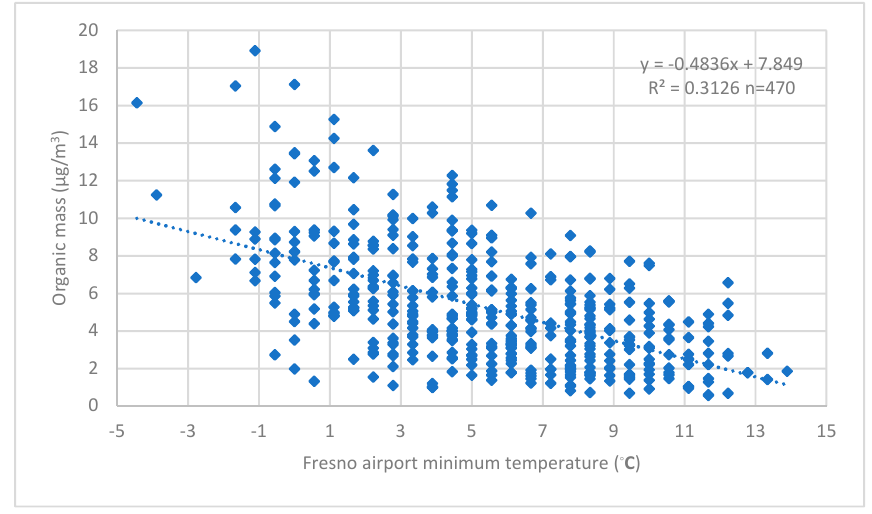
Figure 10. Variation in organic mass with minimum temperature in Fresno.